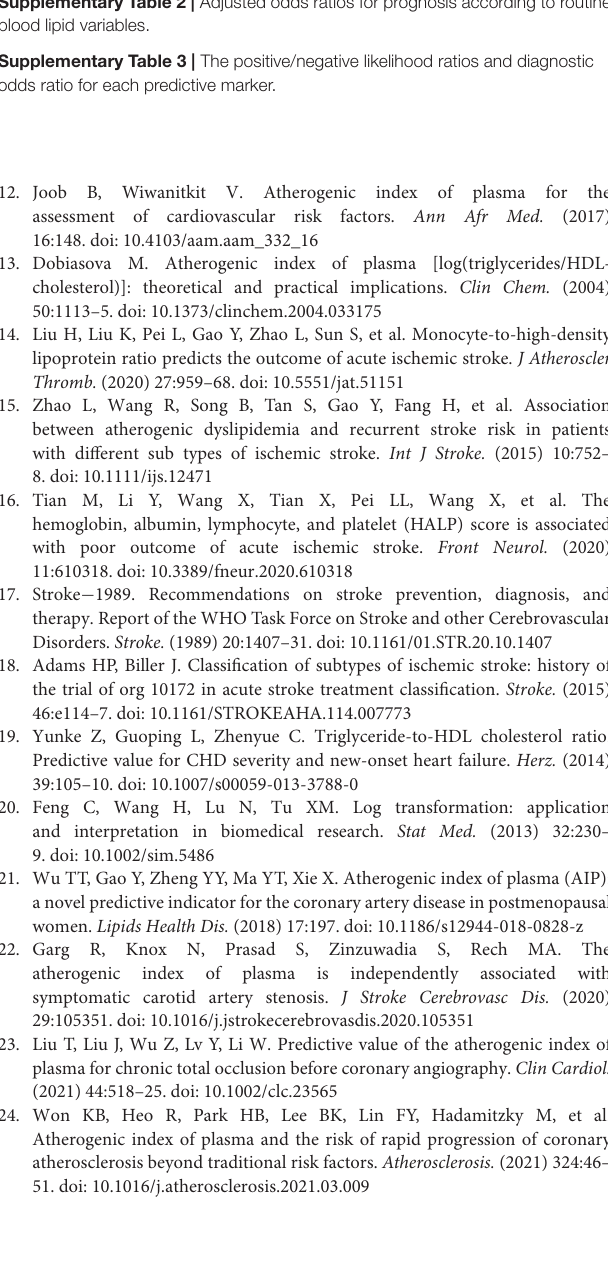
Supplementary Figure 3 | Predictive values of AIP and NIHSS for the outcomes. Receiver operating characteristic curves for outcomes. Supplementary Table 1 | Multivariate logistic regression analysis predicting prognosis after AIS, as continuity variables. Supplementary Table 2 | Adjusted odds ratios for prognosis according to routine blood lipid variables. Supplementary Table 3 | The positive/negative likelihood ratios and diagnostic odds ratio for each predictive